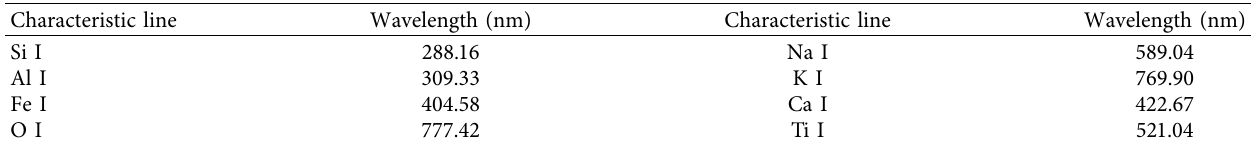
Table 5: Soil spectral line information used in the experiment.